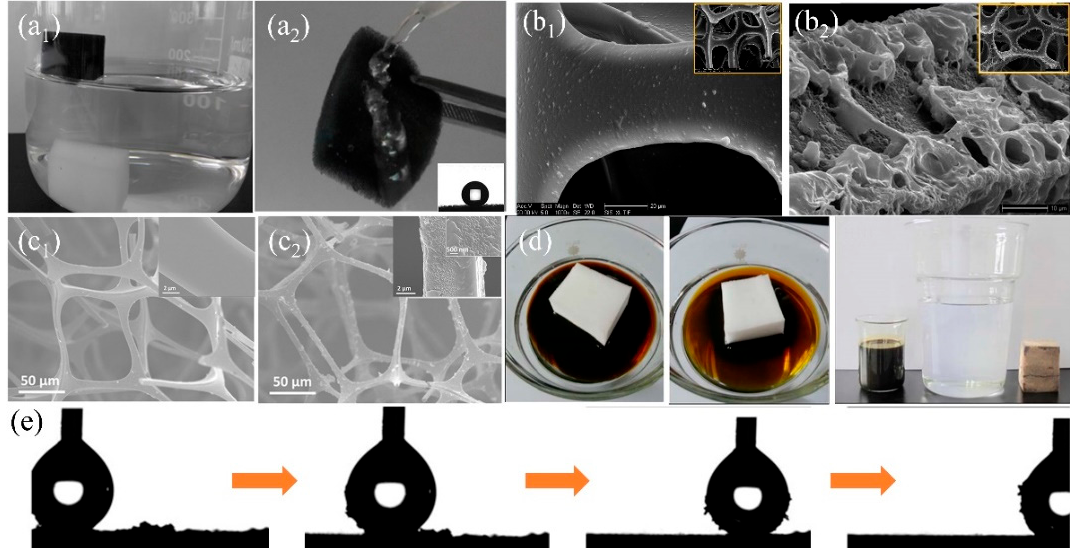
Figure 8. ( a ) The photograph of ( a 1 ) original melamine sponge (sinking under the water) and PANI ‐ melamine sponge (floating on the water), ( a 2 ) the surface of modified sponge rebounding water (the insert is water contact angle (WCA) image) [62]; reproduced with permission from Wiley. ( b ) SEM images of ( b 1 ) the original polyurethane (PU) sponge and ( b 2 ) the PU sponges modified with methyltrichlorosilane [108]; reproduced with permission from Royal Society of Chemistry. ( c ) SEM images of ( c 1 ) original sponge and ( c 2 ) the PANI ‐ melamine sponge [62]. ( d ) Photograph of the KH ‐ 570 PU foam absorbs the crude oil [140]. ( e ) Optical images of the water droplet (5 μ L) removing carbon black particles from the surface of FAS ‐ PU sponge [124]; reproduced with permission from Wiley.